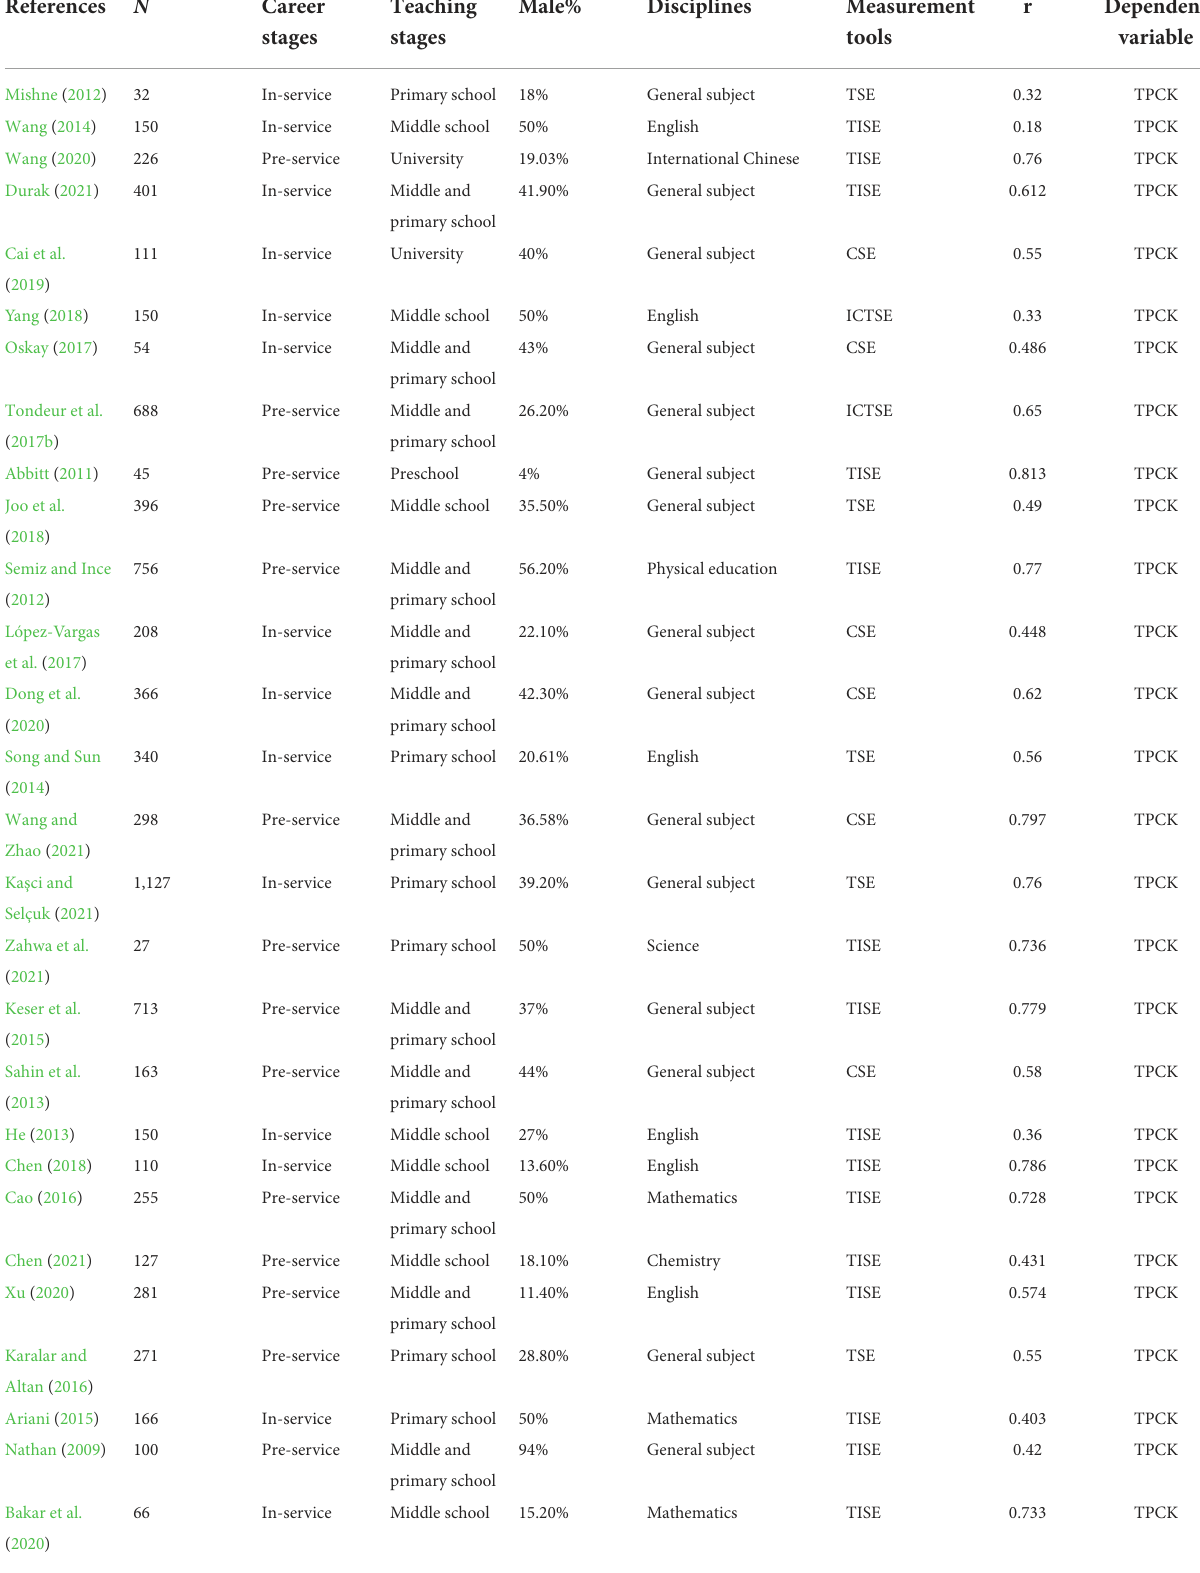
TABLE 1 Basic information of the original study included in the